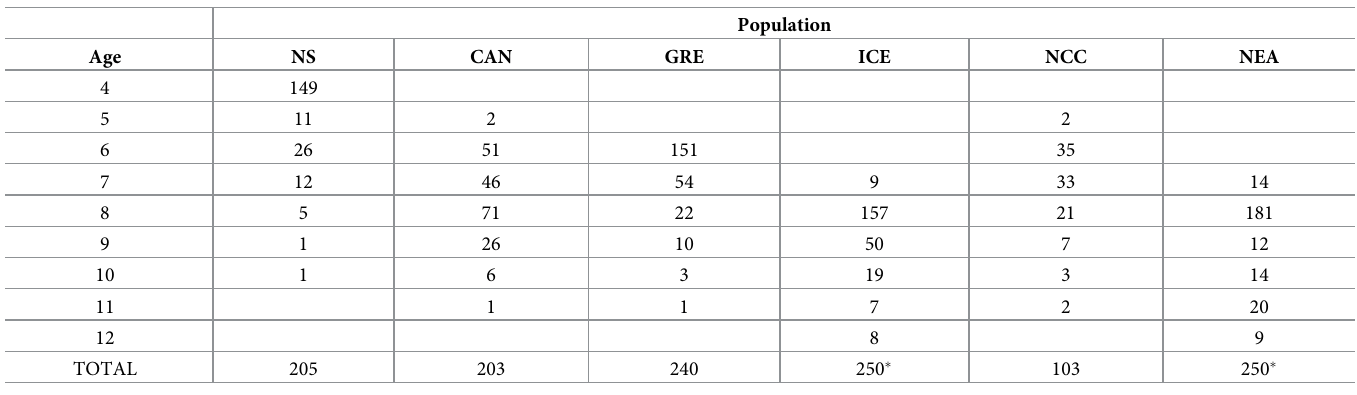
Table 2. Age distribution of the otolith images read from each